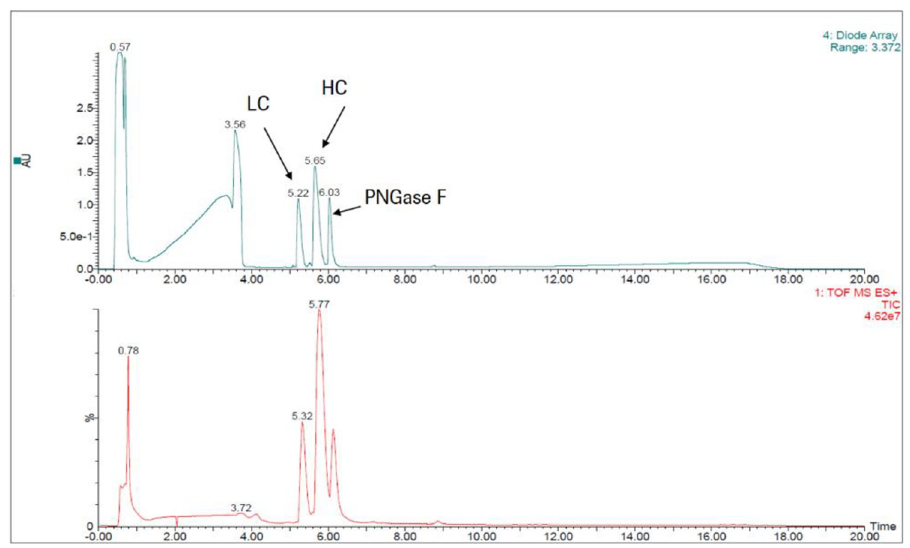
Fig 3. Representative example of a chromatographic separation for subsequent mass spectrometric analysis. LC: light chain; HC: heavy chain; PNGase F: peptide N -glycosidase F.